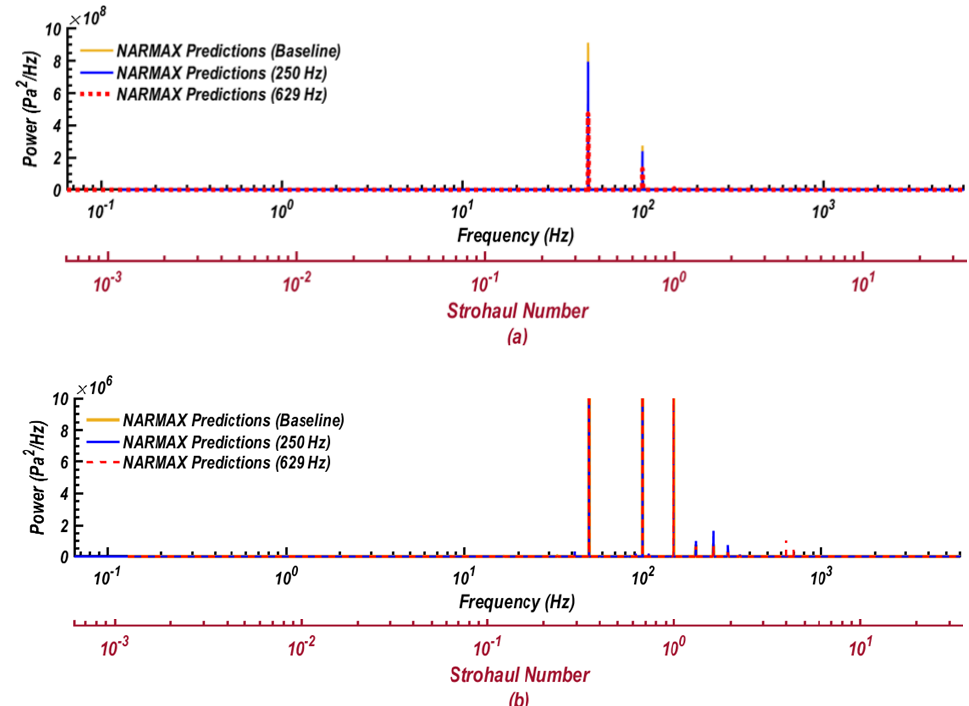
Figure 16. Comparison of the power spectra of the predicted output pressure signals for the baseline and controlled flows with the synthetic jet actuation at 250 Hz and 629 Hz. ( a ) Higher than 10 8 power order and ( b ) in the range (10 6 –10 7